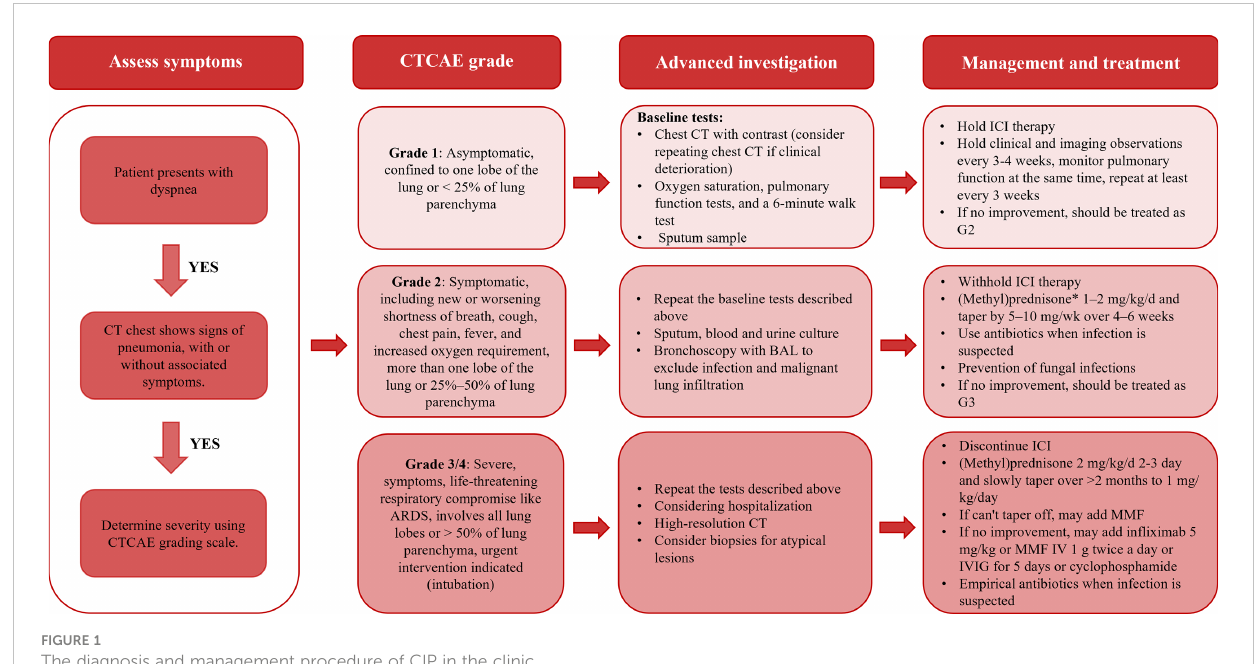
FIGURE 1 The diagnosis and management procedure of CIP in the